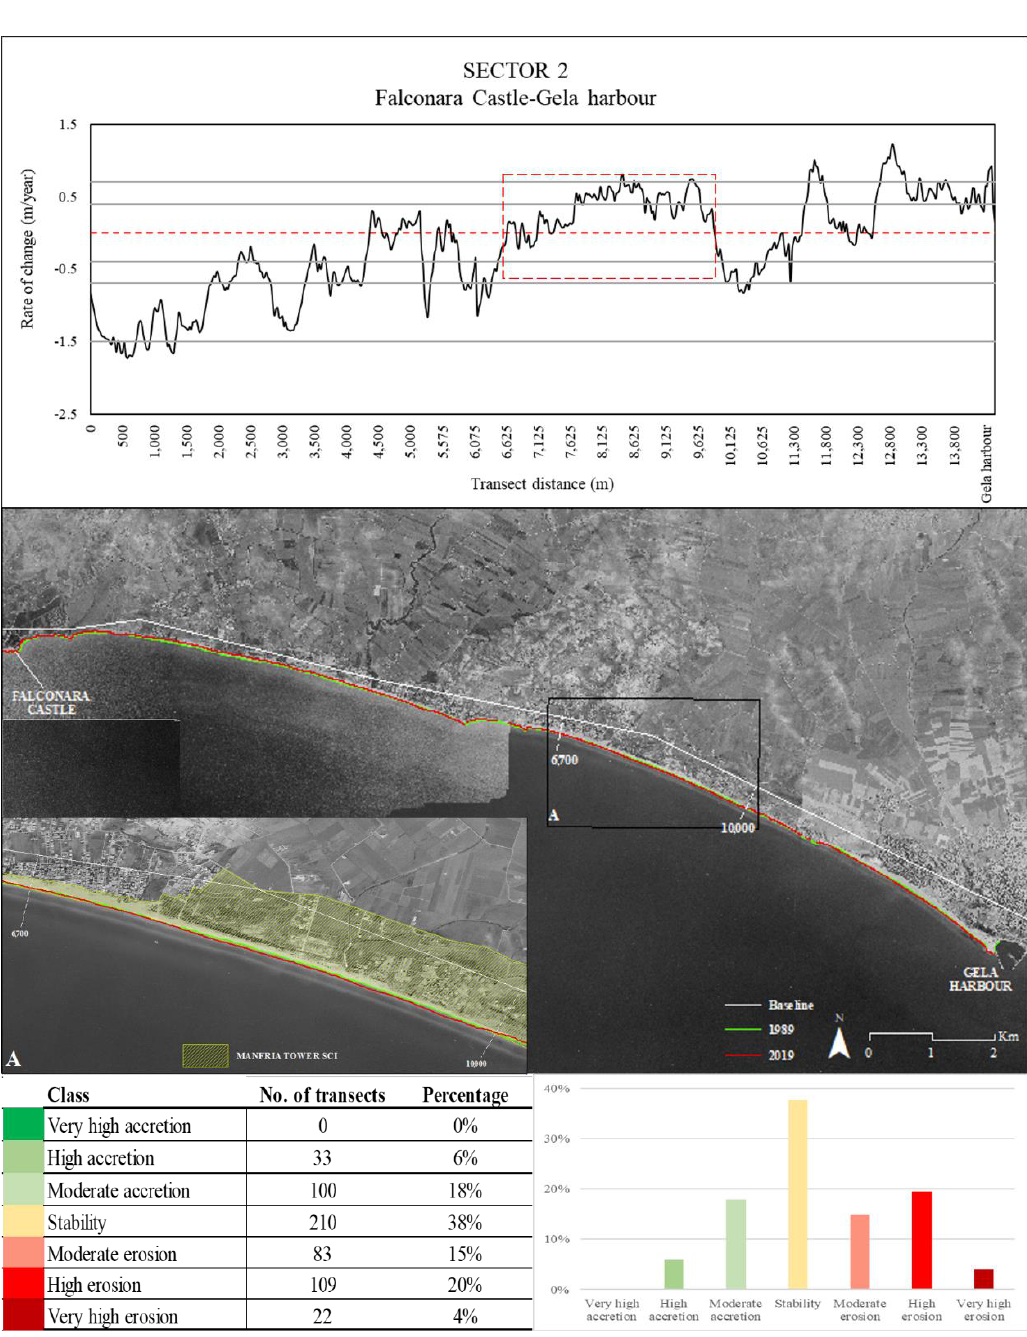
Figure 7. Shoreline evolution over the mid-term period (1989–2019) within sector no. 2. This sector mostly showed a stable trend (38%, 210 transects). In total, 39% of the coast faced moderate to very high erosion (214 transects), and 24% ranged between moderate and high accretion (133 transects). (A) Higher sediment deposition processes have been recorded in correspondence of the Site of Community Importance ITA 050011—Manfria Tower. Grey dashed lines are the transects at 6350 m and at 10,125 m from the westernmost edge of the sector.